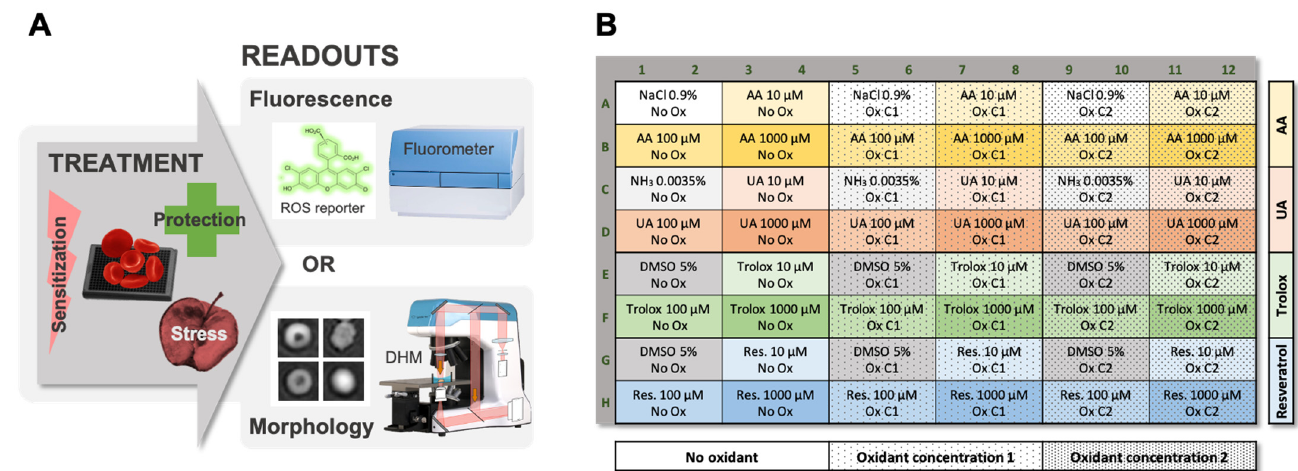
Figure 1. Principle of the TSOX Assay. ( A ) Red blood cells (RBCs) seeded in a microplate are treated with harmful (i.e., oxidant) and/or potentially protective molecules. Two possible readouts giving complementary information are proposed. The first one is based on the detection of fluorescence emitted by the DCFH-DA probe, when exposed to oxidative stress [20]. The second consists in the analysis by digital holographic microscopy (DHM) of the morphological changes triggered by the treatment(s). ( B ) Plate map (96 wells) used in the present